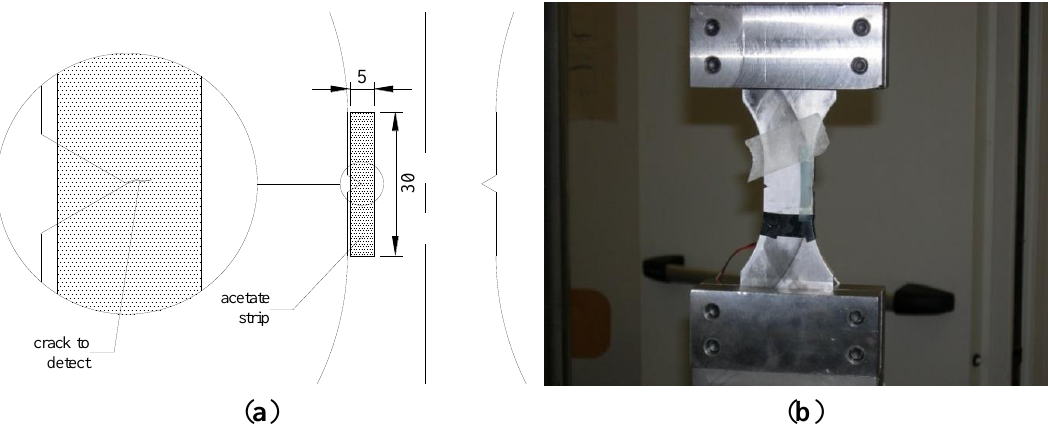
Figure 6. ( a ) Sketch of an acetate strip for surface replication placed over the notch root area; and ( b ) picture of the acetate strip on the specimen.